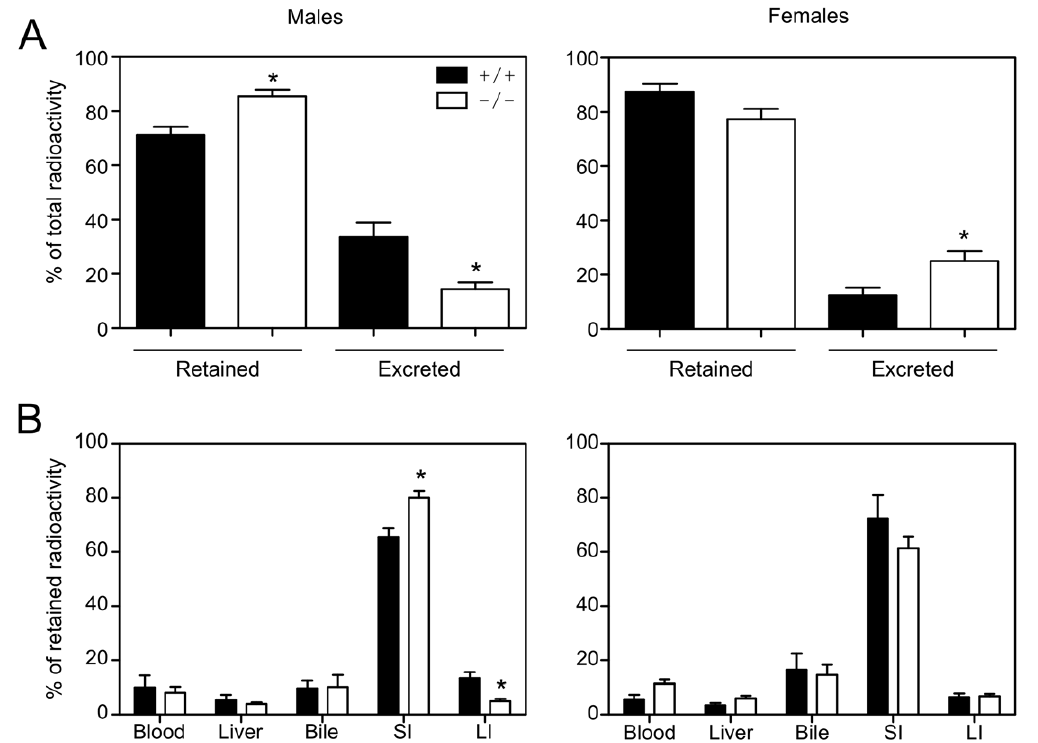
Figure 2. Absorption and tissue distribution of orally administered [ 3 H]TCA in Fabp6 + / + and Fabp6 2 / 2 mice. (A) Retained and excreted [ 3 H]TCA at 24 h after oral administration. Values shown are mean 6 SEM (males, n=4–5; females, n=5–6). (B) Tissue distribution of the retained [ 3 H]TCA in Fabp6 + / + and Fabp6 2 / 2 mice. * P , 0.05, ** P , 0.02, *** P , 0.005, vs. wild-type of the same sex. doi:10.1371/journal.pone.0050810.g002 PLOS ONE |